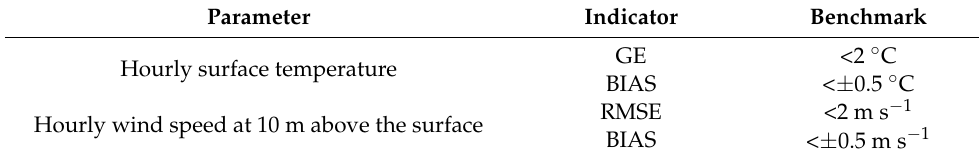
Table 2. Metrics for modeling temperature and wind speed (WRF-Chem 3.2)